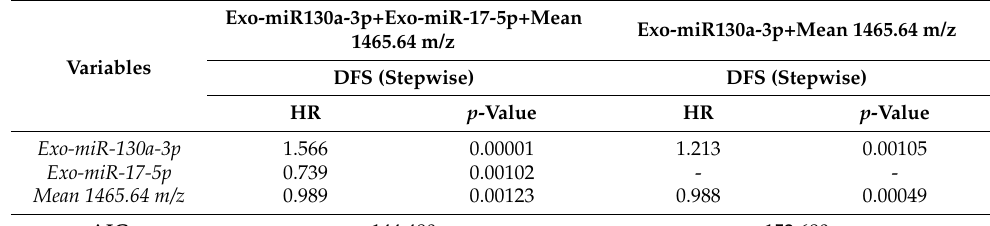
Table 7. Coefficients and relative p -value of the stepwise Cox regression analysis starting from 8 Exo-miRs (ddPCR data) combined with 4 peptides, or from Exo-miR-130a-3p alone combined with 4 peptides (n = 46). AIC (Akaike Information Criterion) values of the models are reported.